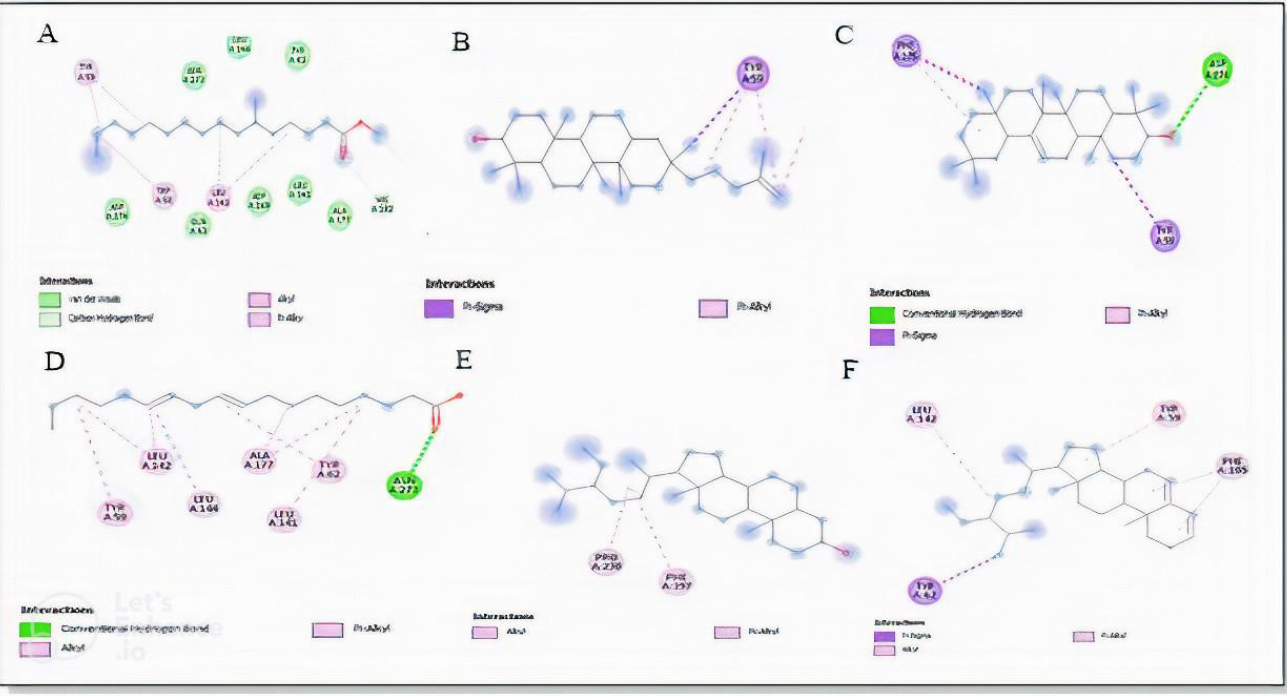
Figure 6. Molecular docking of selected ligands with tyrosinase enzyme. ( A) Ligstroside, ( B) Ru- tin, ( C) Scutellarin, and ( D) Kojic acid.